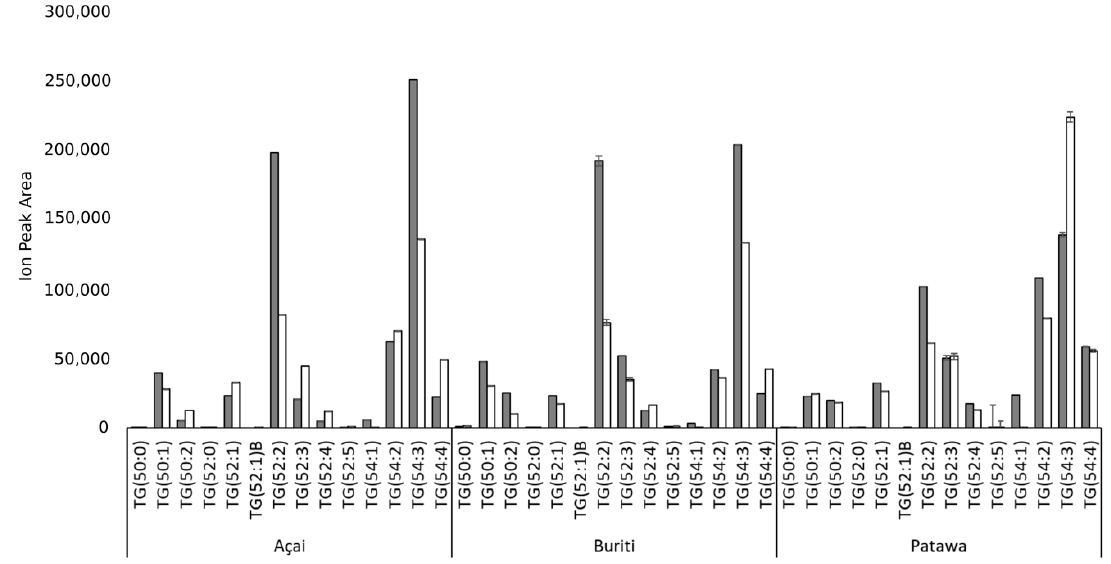
Figure 4. Comparison of the triglycerides (TG) content according to extraction method (mechanical extraction—grey bars; solvent—white bars) for açai, buriti, and patawa oils.